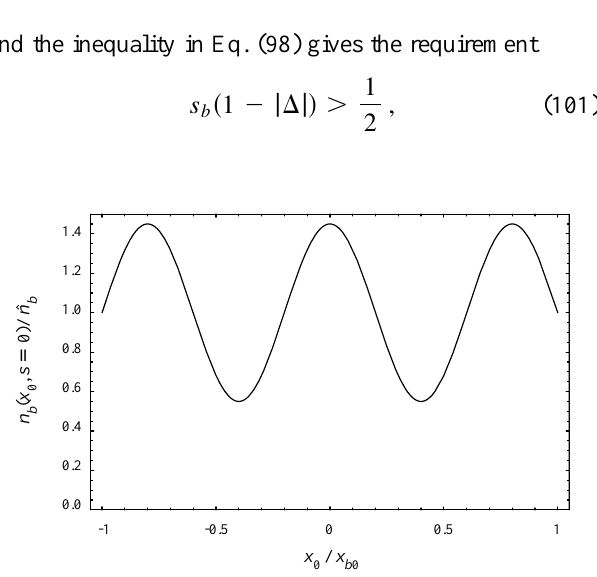
(cid:1) x , s (cid:2) , t (cid:1) s (cid:5) obtained numerically for the choice of n b (cid:4) x 0